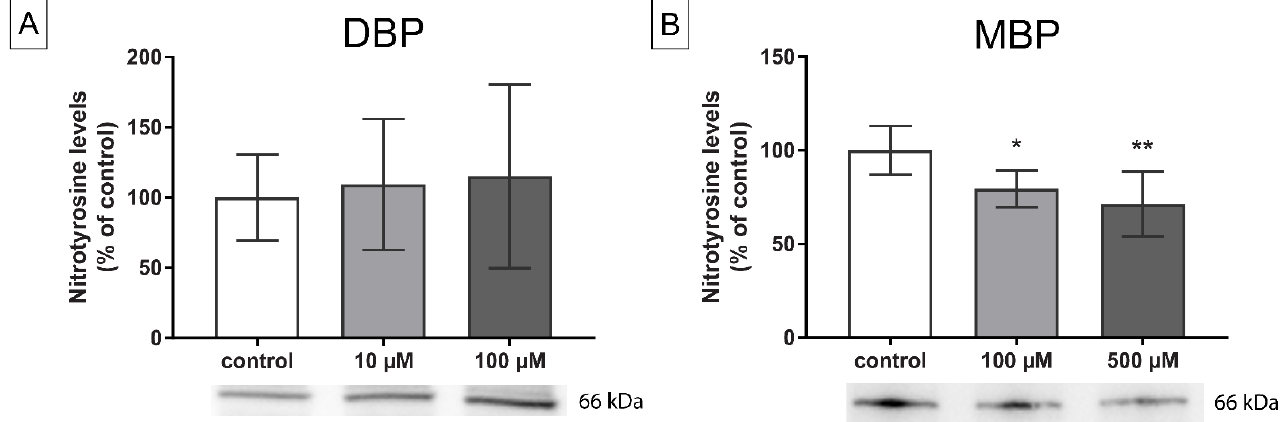
Figure 7. Changes in nitrotyrosine levels in H295R cells after 48 h exposure to DBP ( A ) or MBP ( B ), with stimulation of the steroidogenesis by 0.1 mM dbcAMP, were measured by western blot. Representative blots are shown. Total protein stain was used as a loading control. Values represent mean ± S.D. from six wells per concentration. Statistically significant differences from control are indicated as follows: * p < 0.05, ** p < 0.01 (One-way ANOVA followed by Dunnet’s test).